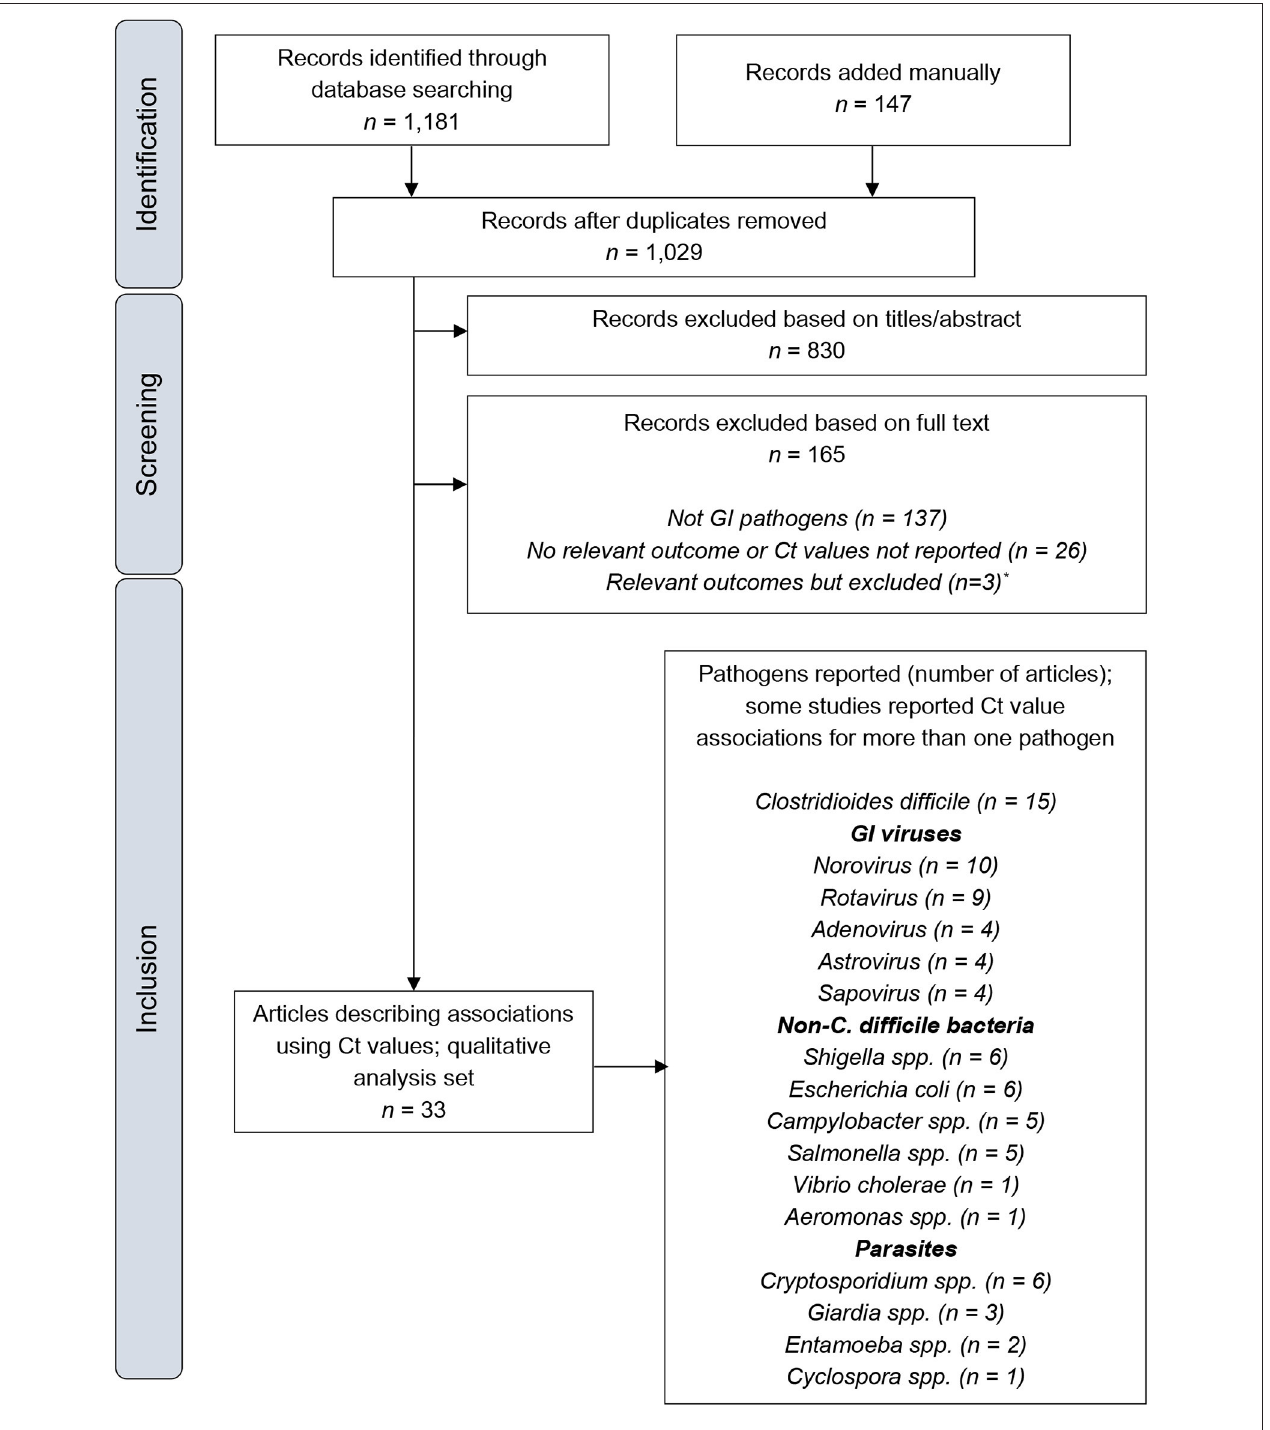
FIGURE 1 | PRISMA flow diagram. Ct, cycle threshold; GI, gastrointestinal. *Details of these publications are provided in the Supplementary Material .